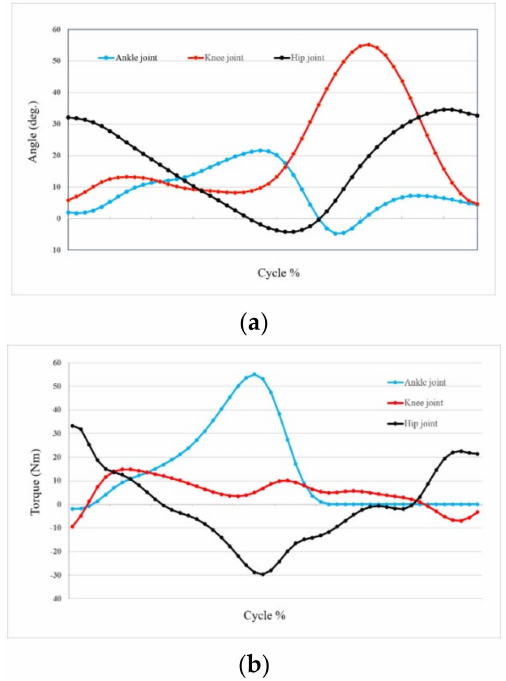
Figure 19. Variation-patterns of human joint motion angles and torques: ( a ) Chart of lower limb joint motion angle; ( b ) Chart of lower limb joint motion